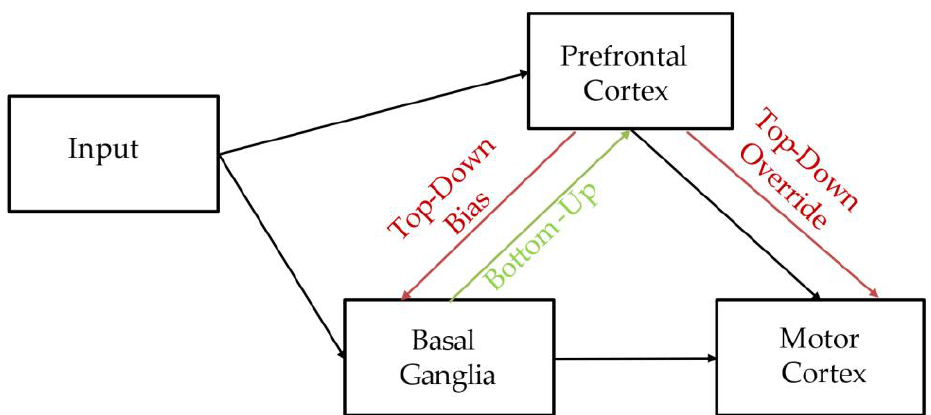
Figure 5. Diagram depicting neural network accounts of instructional control over reinforcement learning. Red lines indicate projections with differing computational roles. Instruction representations from PFC via top-down projections either directly bias the BG valuation, selection, and learning (bias model), or override BG learning of probabilities through the competition at motor cortex (override model) (red line). Bottom-up connections between BG and PFC enable updating of the cortical value of falsely instructed stimuli (green line).